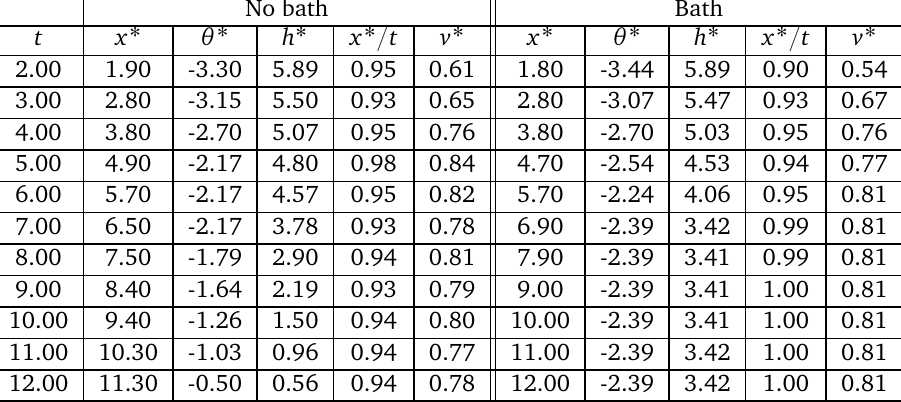
Table 1: Numerical results for the subsidiary peak of the spectral density of particle “ 0) and presence (2 T “ e 3 ) of a bath. The other parameters ( ` ) in the absence ( T a a “ 2 e 7 as before. x ˚ , θ ˚ and h ˚ are the phase-space are fixed to σ “ 10 and T m coordinates and the height of the local maximum of the subsidiary peak, respectively and v ˚ ” v eff, ` p x ˚ , t , θ ˚ q . The quantity x ˚ { t represents the observed propagation velocity of the subsidiary peak of particle ( ` ) resulting from its interaction with the interacting peak of particle ( ´ ) which propagates at speed ` 1. The numerical uncertainty of phase-space coordinates is ∆ x ˚ “ 0.10 and ∆ θ ˚ “ 0.07 to 0.08, with lower rapidity resolution for less negative values of θ ˚ (as discussed in Appendix